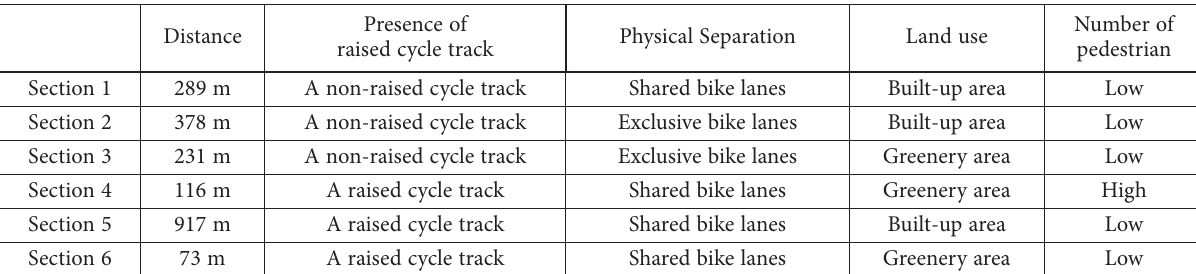
Table 1. The characteristics of cycling route per each section